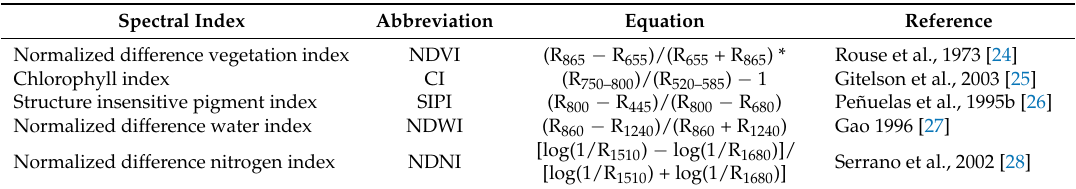
Table 3. Spectral indices calculated from the measured reflectance and transmittance spectra. R ## denote the wavelengths used in the